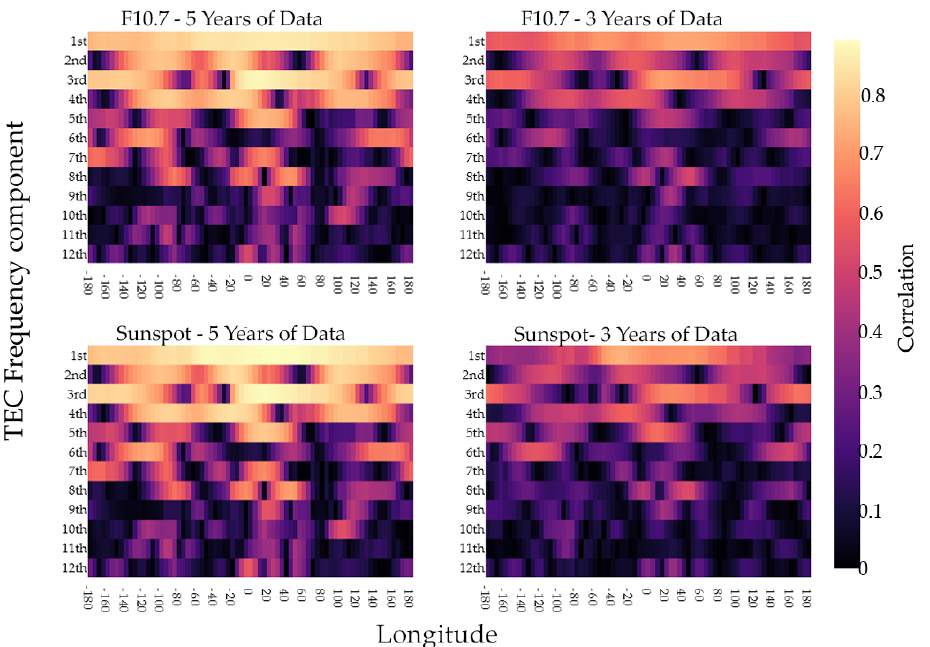
Figure 7. Correlation heatmap for F10.7 and sunspot at geomagnetic latitude 22.5 ◦ N. TEC frequency components range from 0 to 0.25 cicles-per-hour.